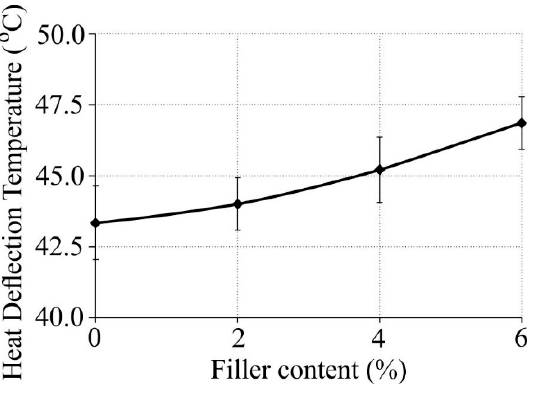
Figure 3. Heat deflection temperature (HDT) versus nanofiller mass content in the composite.